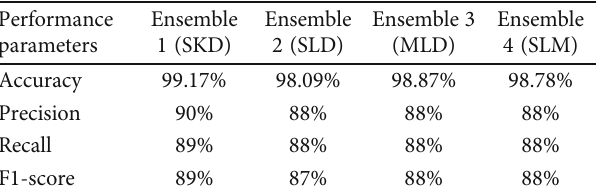
Table 4: Performance of ensemble classi fi ers on dataset 4.